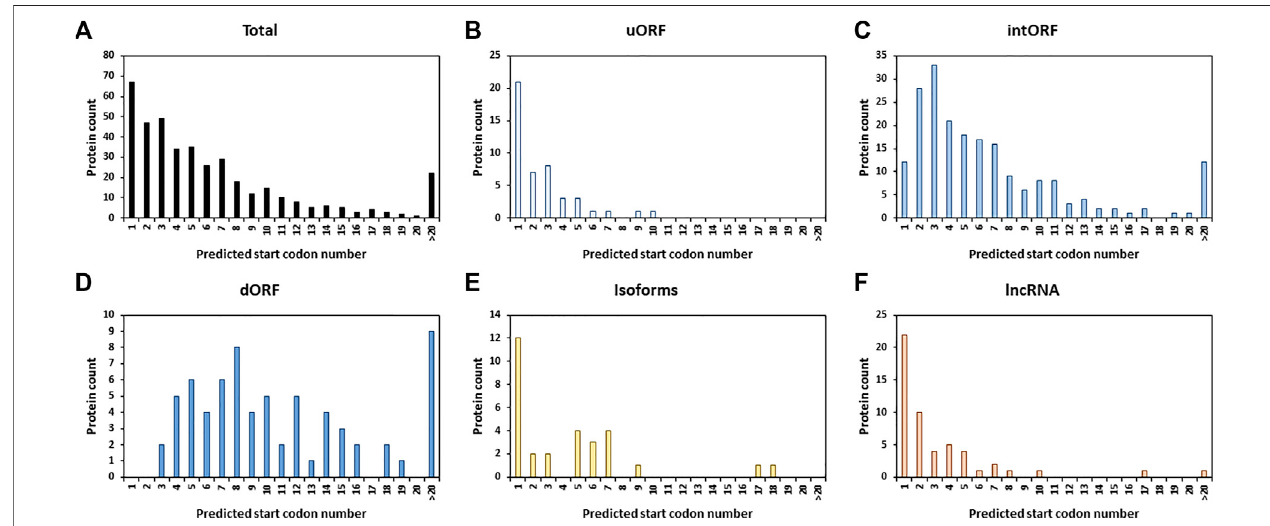
FIGURE 3 | Alternative proteins are not mainly produced from the fi rst predicted ORF. Distribution of the alternative proteins counts depending on the order of the positionofthepredictedstartcodonsforallthenewlyidenti fi edproteins(total) (A) ,isoforms (B) ,proteinsidenti fi edfromORFsencodedbylncRNA (C) ,uORF (D) ,AltCDS (E), or dORF (F) on